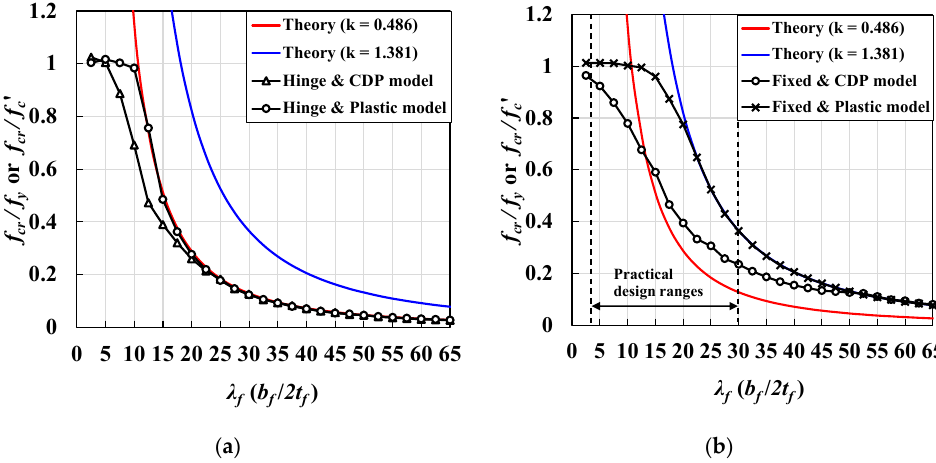
Figure 14. Relationship between compressive stress and out-of-plane deflection for UHPC flanges modeled using the CDP material model according to slenderness ratio ( λ f ): ( a ) hinge support condition and ( b ) fixed support condition.